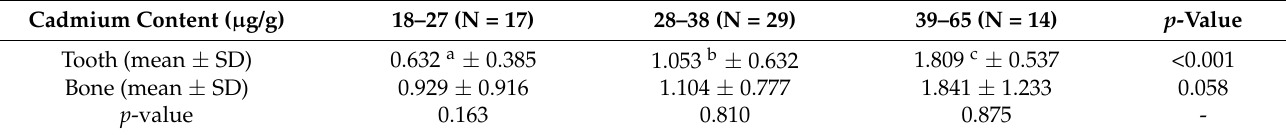
Table 5. Cadmium content in tested samples taken from patients of different age.